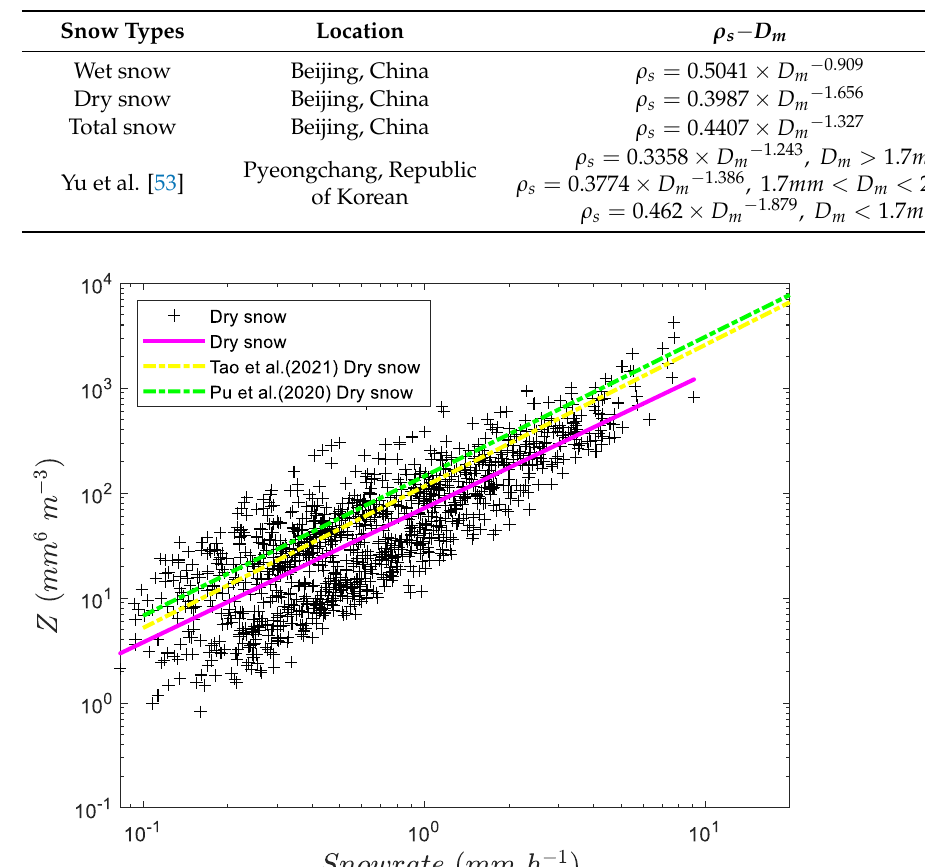
Figure 9. Scatterplots of 𝑍 𝑒 and 𝑆𝑅 of all snowfalls and 𝑍 𝑒 − 𝑆𝑅 relationship fitting [54,55].